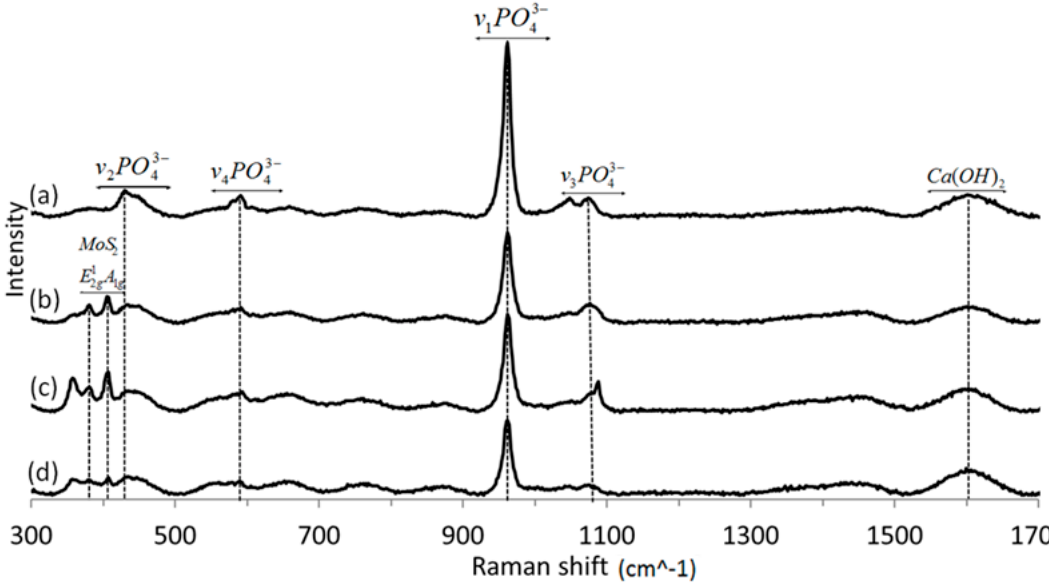
Figure 7. Raman spectra of HA powder film without ( a ) and with the Re:IF-MoS 2 nanoparticles obtained from solution A for different EPD periods: after 2 ( b ), 3 ( c ) and 4 h ( d ). Table 3. Summary of the initial and final friction coefficients and the initial roughness for different stages of preparation of the composite HA + IF film. Measurement conditions: diameter of the test ball 10 mm; load = 10 g (Hertzian pressure—P = 150 MPa).